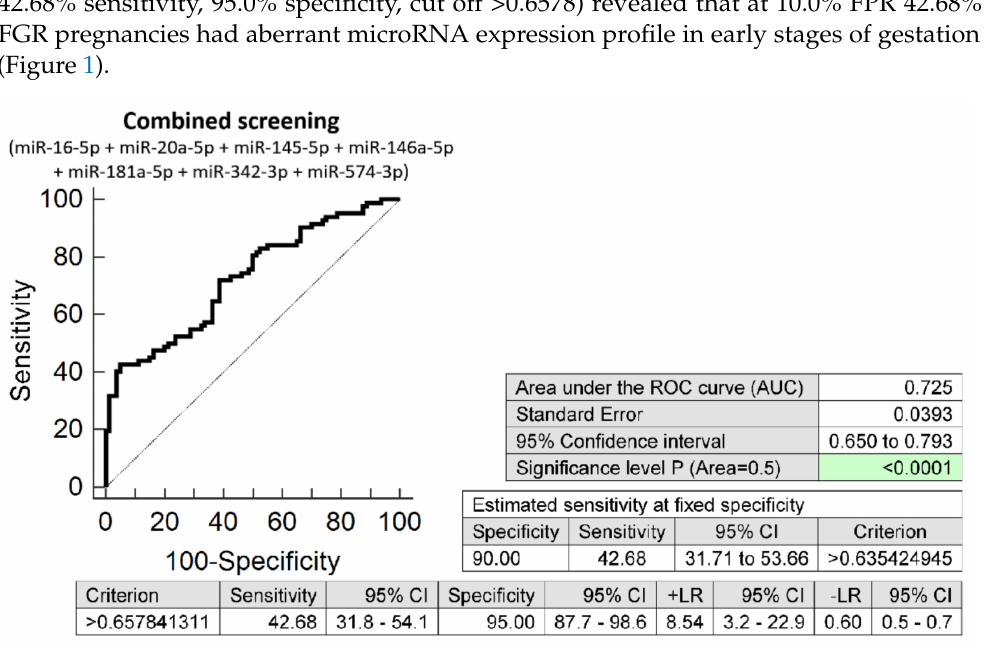
Figure 1. ROC analysis—the combination of microRNA biomarkers. The combination of miR-16- 5p, miR-20a-5p, miR-145-5p, miR-146a-5p, miR-181a-5p, miR-342-3p, and miR-574-3p showed that at 10.0% FPR 42.68% FGR pregnancies had aberrant microRNA expression profile in the whole peripheral venous blood during the first trimester of